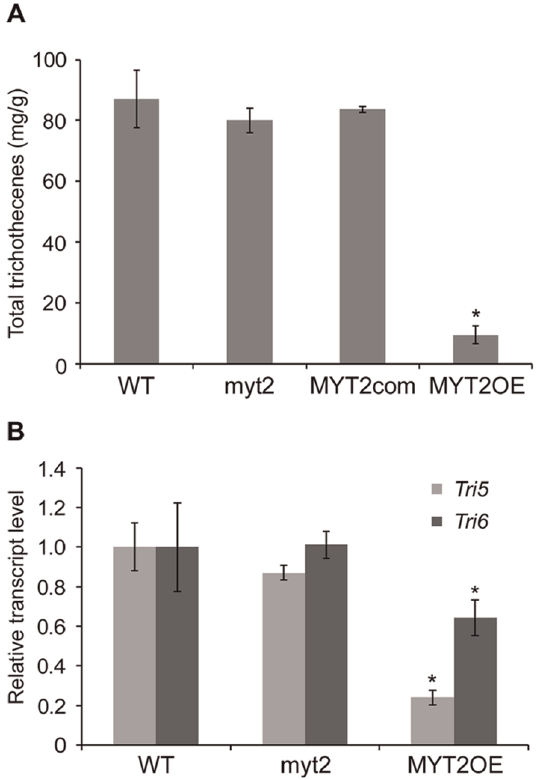
deoxynivalenol) production and transcriptional analyses of trichothecene synthetic genes. (A) Each strain was grown in minimal medium supplemented with 5 mM agmatine for 7 d. Trichothecenes were analyzed by GC-MS and quantified based on the biomass produced by each strain. Asterisks indicate data that significantly differed ( p , 0.05) based on Tukey’s test (B) Expression of Tri5 and Tri6 in the wild-type, MYT2 deletion, and MYT2 overexpression strains. Gene transcription was analyzed by quantitative real time-PCR (qRT-PCR) 4 d after inoculation in MMA. WT, G. zeae wild-type strain Z- 3639; D myt2 , MYT2 deletion mutant; MYT2com, D myt2 -derived strain complemented with MYT2 ; MYT2OE, transgenic strain that has the EF1 a promoter inserted in place of the MYT2 promoter region.